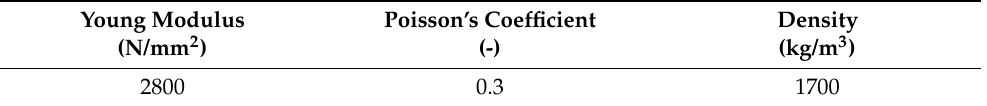
Table 6. Mechanical parameters assigned to the masonry, modelled as a linear elastic isotropic material. Young